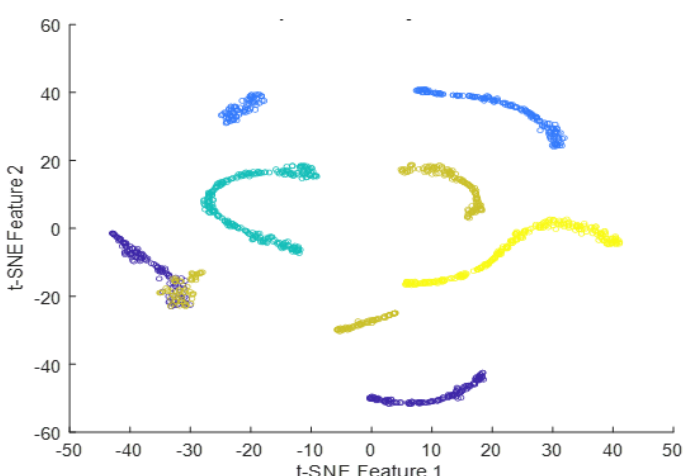
Figure 17. t-SNE plot of the extracted features from the fully-connected layer for dataset#2.